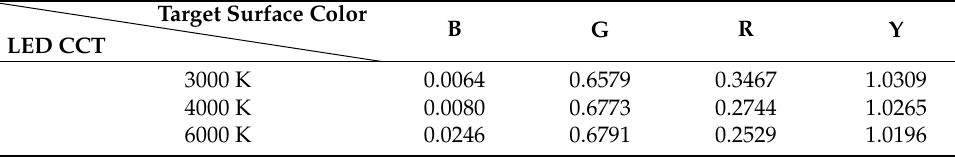
Figure 14. L channel images of the four-color targets under three lighting conditions. The C values of the target for each lighting environment according to Equation (10) are presented in Table 3. Table 3. Contrast value of target